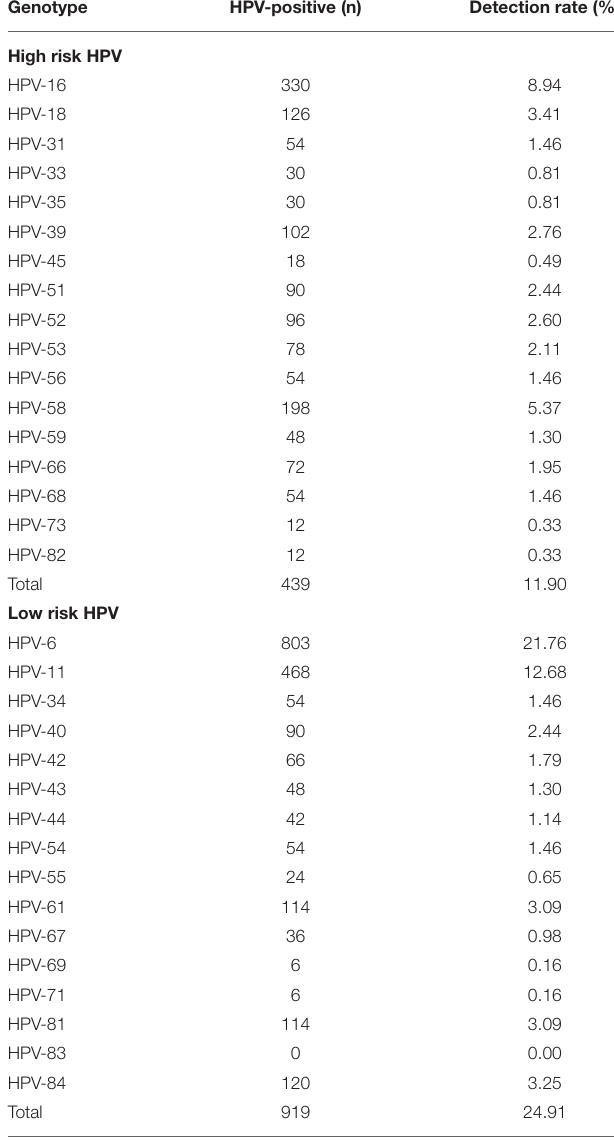
TABLE 2 | Detection rate of HPV genotype among